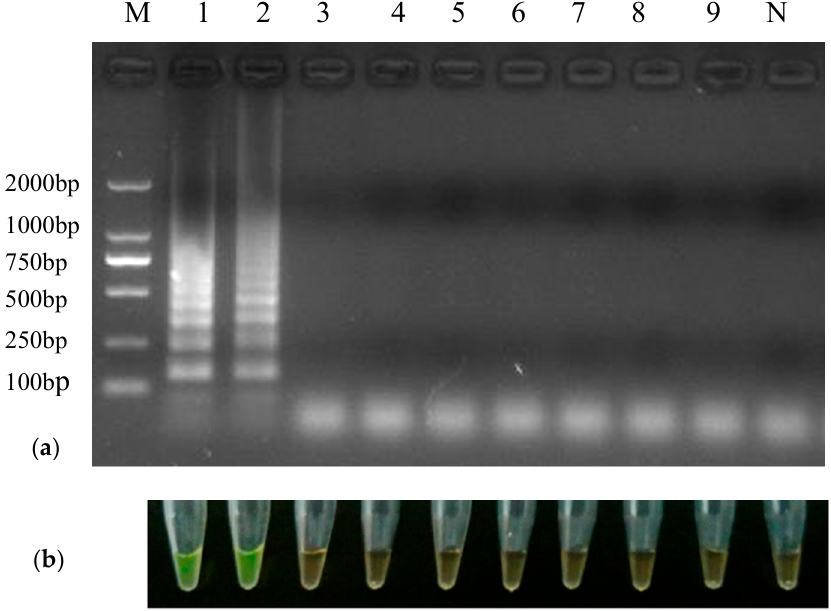
Figure 2. Specificity of RT-LAMP for PEDV. Amplified products of RT-LAMP were visualized by agarose gel electrophoresis ( a ) and coloration agent ( b ). Lane M: DL2000 DNA marker; Lane 1: positive control; Lanes 2–9: PEDV, PPV, PCV1, PCV2, PRV, PRRSV, RV and TEGV, respectively; Lane N: negative